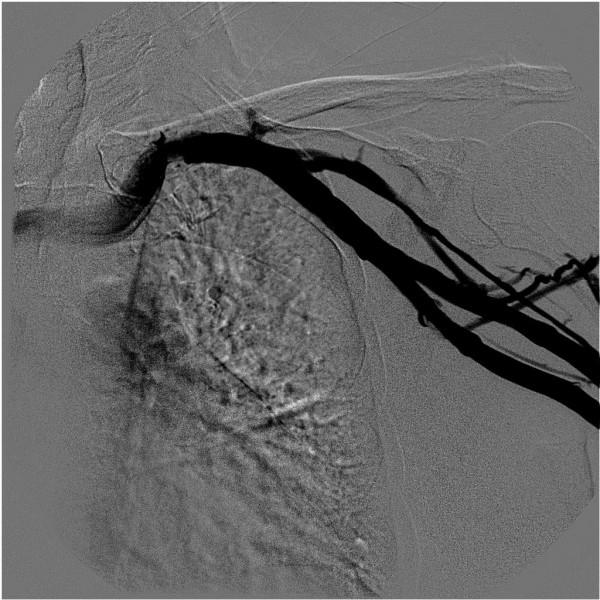
Puncture of V. Subclavia – demonstration of V. Subclavia with contrast agent.